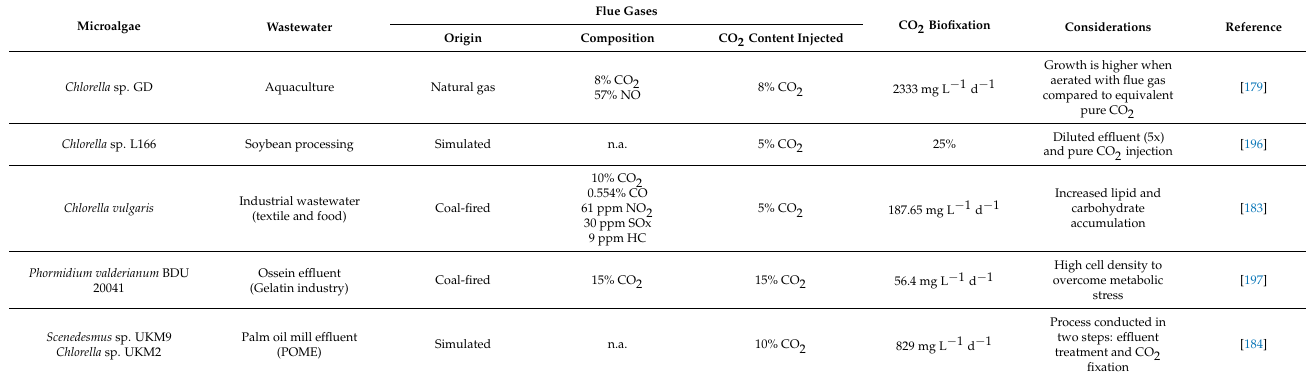
Table 4. Overview of reports that have evaluated integrated mixotrophic culture with wastewater treatment and CO 2